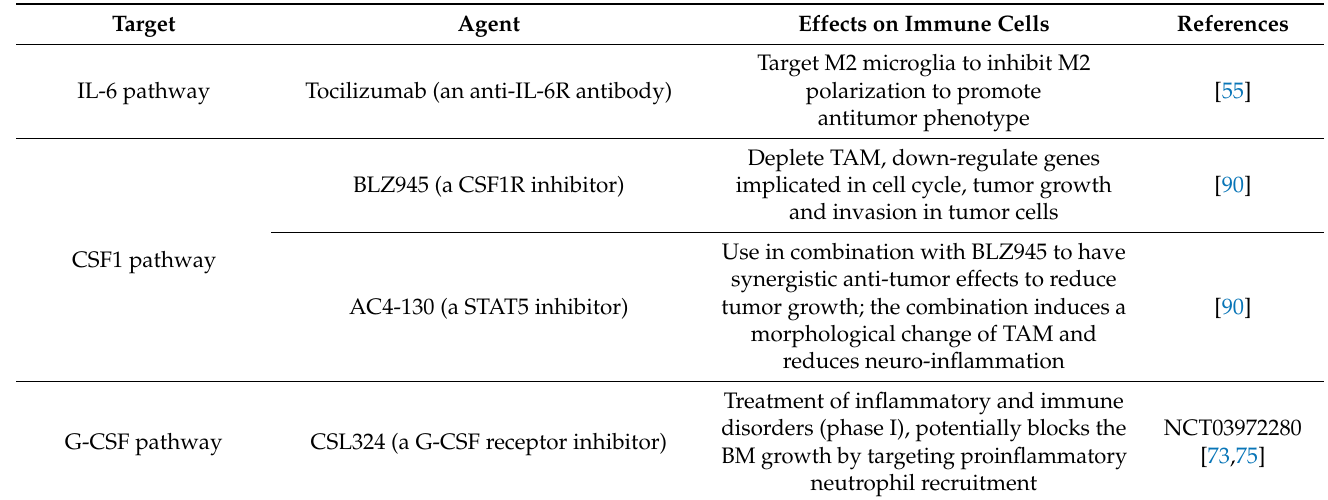
Table 1. Promising treatments targeting cytokines involved in BM